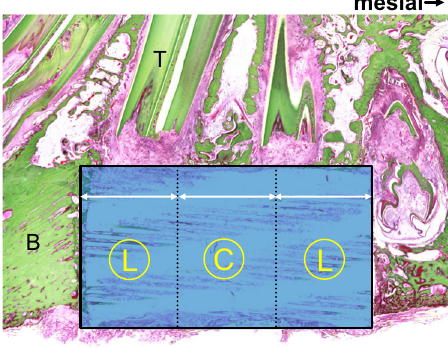
Fig. 2 Compartments for the microscopic analysis of regenerated bone and residual CO 3 Ap in the defects. The right direction of the fi gure shows the mesial aspect. Specimens were divided into three parts, that is, the central part (C) and the lateral parts at both ends (L). “ B ” indicates the cortical bone of the inferior border of the mandible. “ T ” indicates